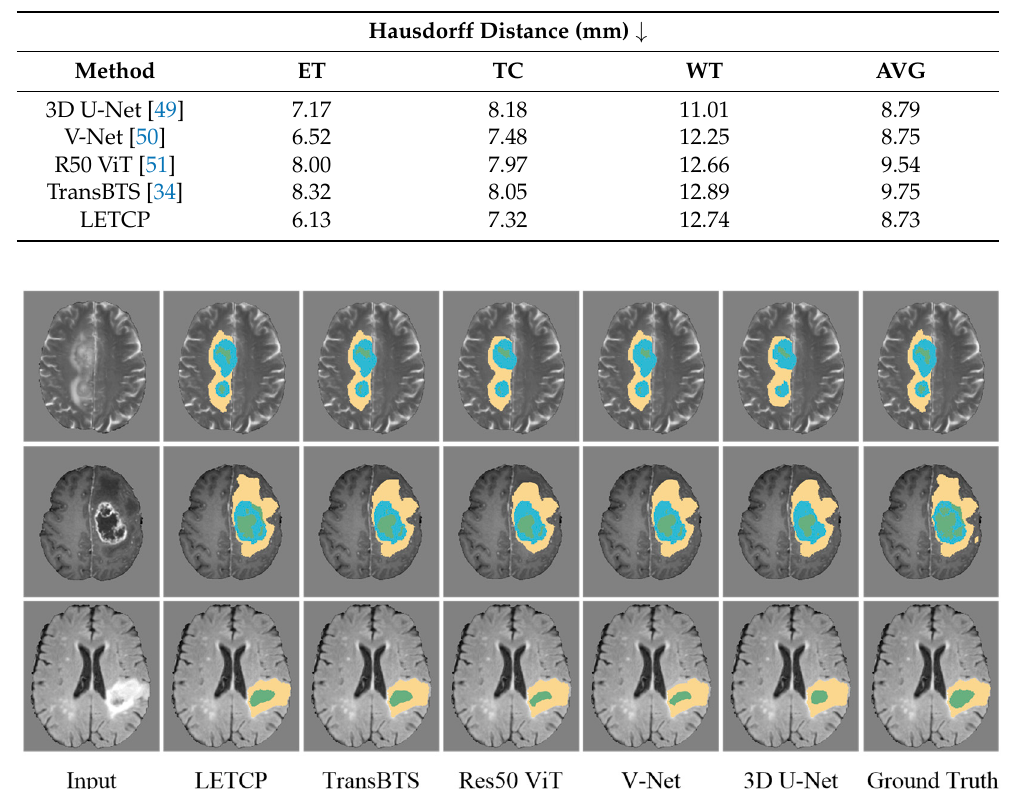
Figure 4. Qualitative comparison of segmentation performance between LETCP and other baselines. Yellow represents whole tumor region, blue represents enhancing tumor region and green represents region of tumor core.